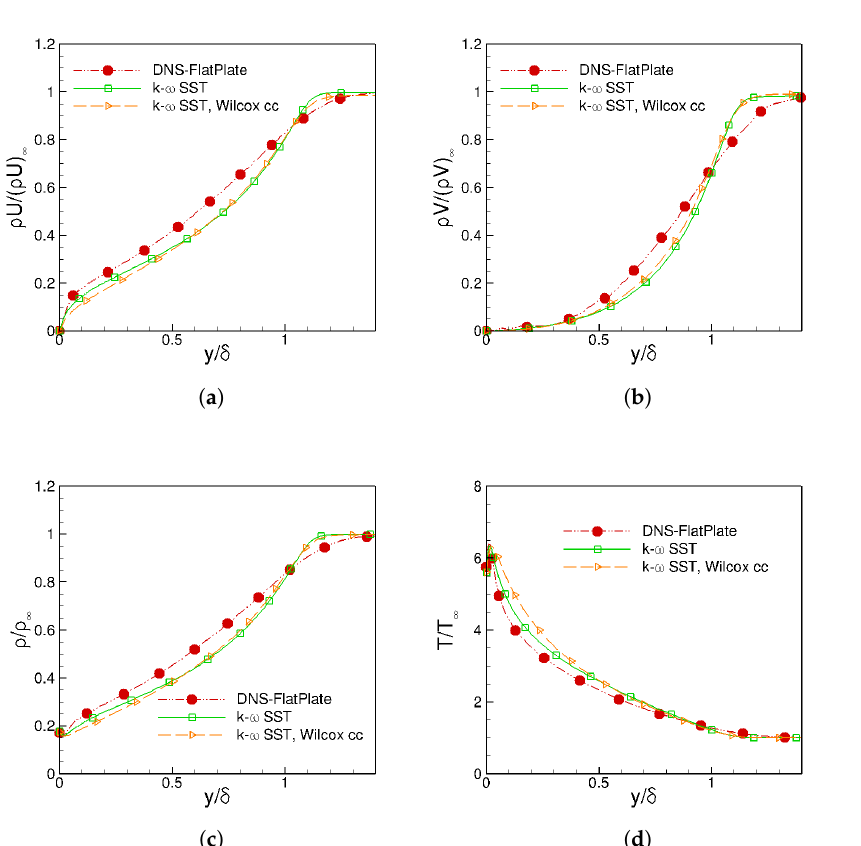
Figure 8. Comparison of mean boundary-layer profiles at Re τ ≈ 500 between DNS and RANS using k - ω SST with and without compressibility corrections. ( a ) Mean mass flux ρ U ; ( b ) mean wall-normal mass flux ρ V ; ( c ) mean density ρ ; ( d ) mean temperature T